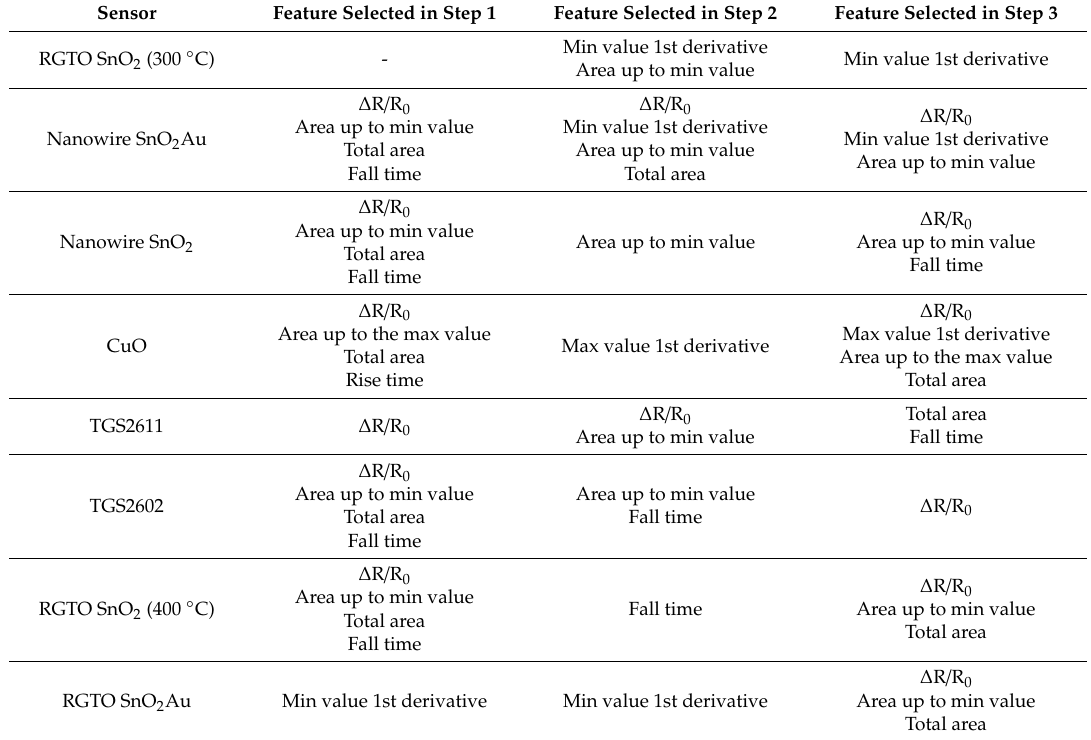
Table 3. List of the features selected at each step of the analysis.